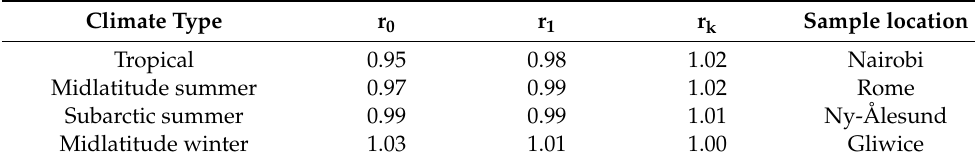
Table 1. Coefficients for climate type and sample